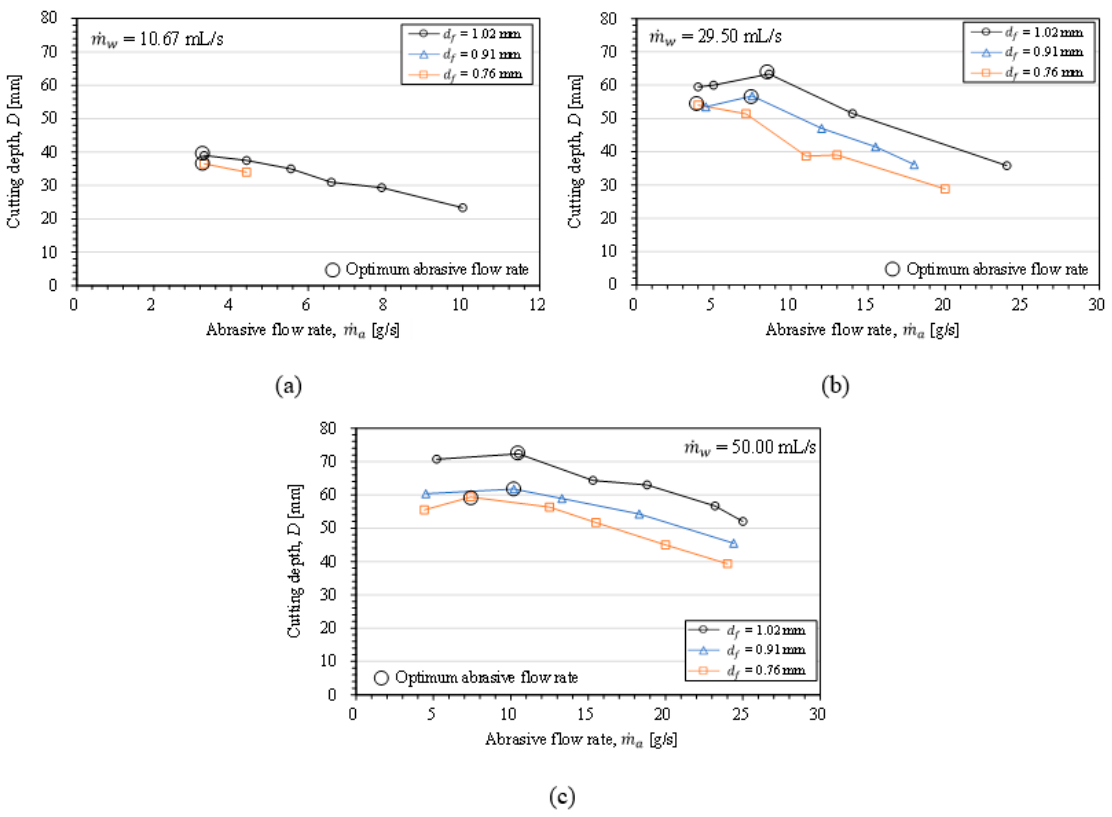
Figure 8. Rock cutting depth as a function of focus diameter at WFRs of ( a ) 10.67, ( b ) 29.5, and ( c ) 50.00 mL/s.